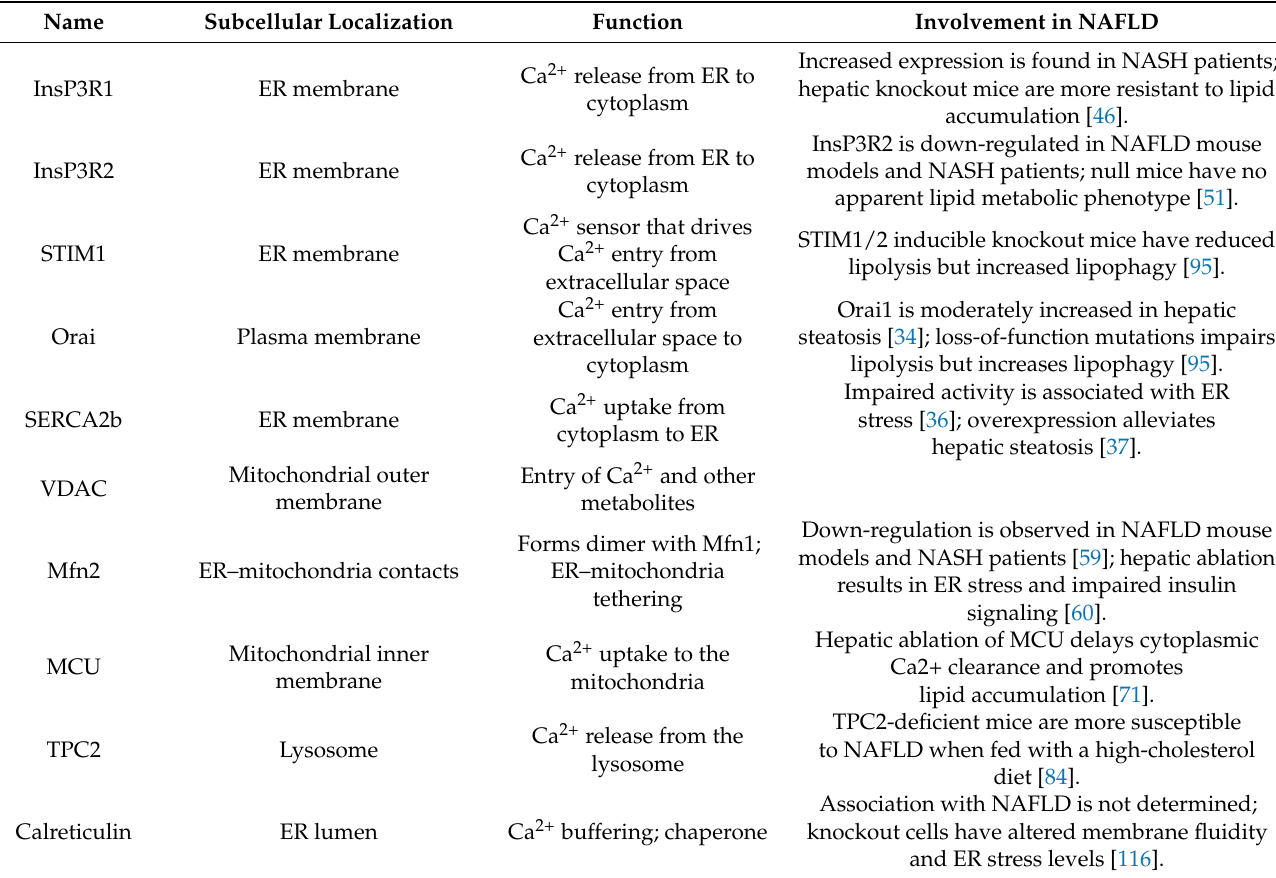
Table 1. Key regulators of Ca 2+ signaling in hepatic lipid